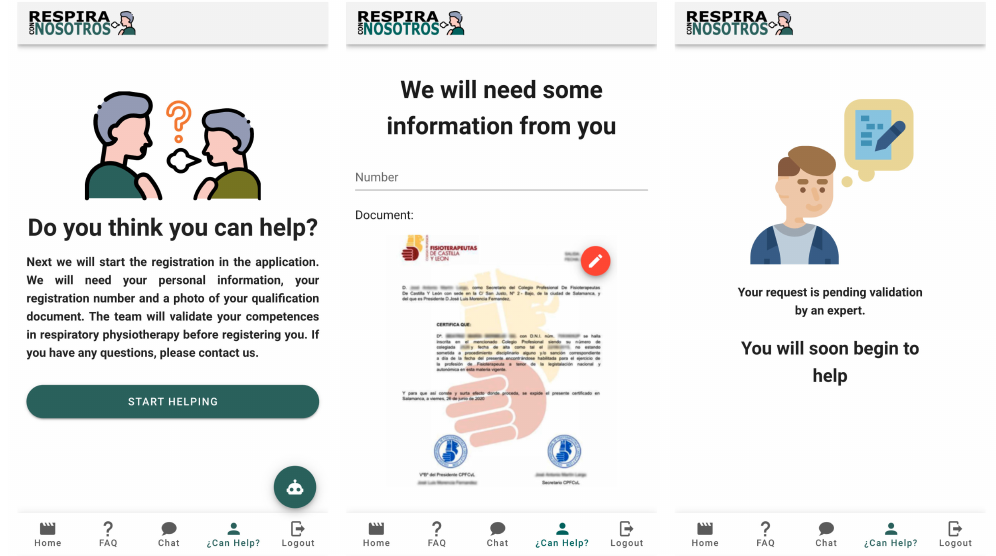
Figure 8. Professional